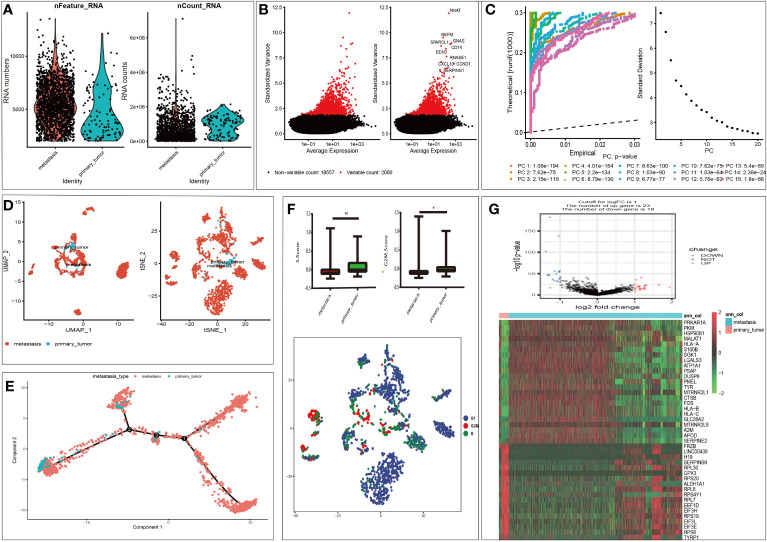
Characterization of single cell sequencing from 1958 malignant melanoma cell samples and screening of differentially expressed metastasis related genes (MRGs). (A) Quality control of single cell RNA sequencing for primary and metastasis sub-populations. The Y axes represent RNA numbers and RNA counts of each cell respectively. We filtered out the cells with poor quality and analyzed the detected gene counts and sequencing depth in sub-populations. (B) We calculate a subset of features that exhibit high cell-to-cell variation in the dataset. Red dots mean the 2000 variable genes. The top 10 gene names are labeled out. (C) The JackStrawPlot and ElbowPlot of principal components, which were used to identify the significantly available dimensions of data sets with estimated P value and Elbow. The JackStrawPlot function provides a visualization tool for comparing the distribution of p-values for each PC with a uniform distribution (dashed line). There is a sharp drop-off in significance after the first 14 PCs (solid curve above the dashed line). We can also observe an “elbow” around PC14-15 in ElbowPlot. (D) Based on available significant components, we conducted UMAP and t-SNE algorithm. The goal of these algorithms is to learn the underlying manifold of the data in order to place similar cells together in low-dimensional space. Compared to UMAP, t-SNE can successfully divided the cells into two clusters (primary and metastasis sub-populations). (E) Pseudotime and trajectory analysis revealed the tendency curve from primary melanoma to metastatic ones. Y-axis means the value of principal component 1 (the first principal direction of maximum sample change) and X-axis means the value of principal component 2 (the second principal direction of maximum sample change). This analysis can place each cell at the proper pseudotemporal position along this trajectory. (F) Cell cycle annotation in t-SNE map. There are different cell cycle patterns between primary and metastasis sub-populations. *P < 0.05, **P < 0.01. (G): Volcano plot of differentially expressed MRGs and heat map of the differentially expressed MRGs. Red and green indicate higher expression and lower expression, respectively. The pink bar stands for primary tumor sample and the blue bar stands for metastasis sample.